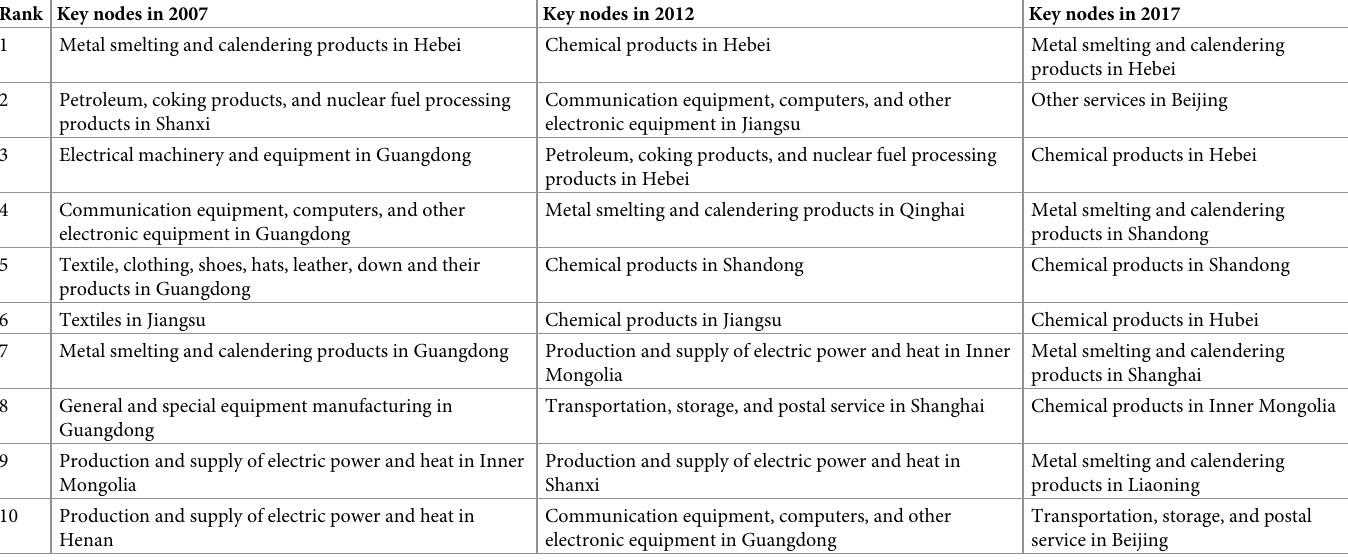
Table 2. Top ten key node sectors of the embodied carbon flow networks of China’s exports. Rank Key nodes in 2007